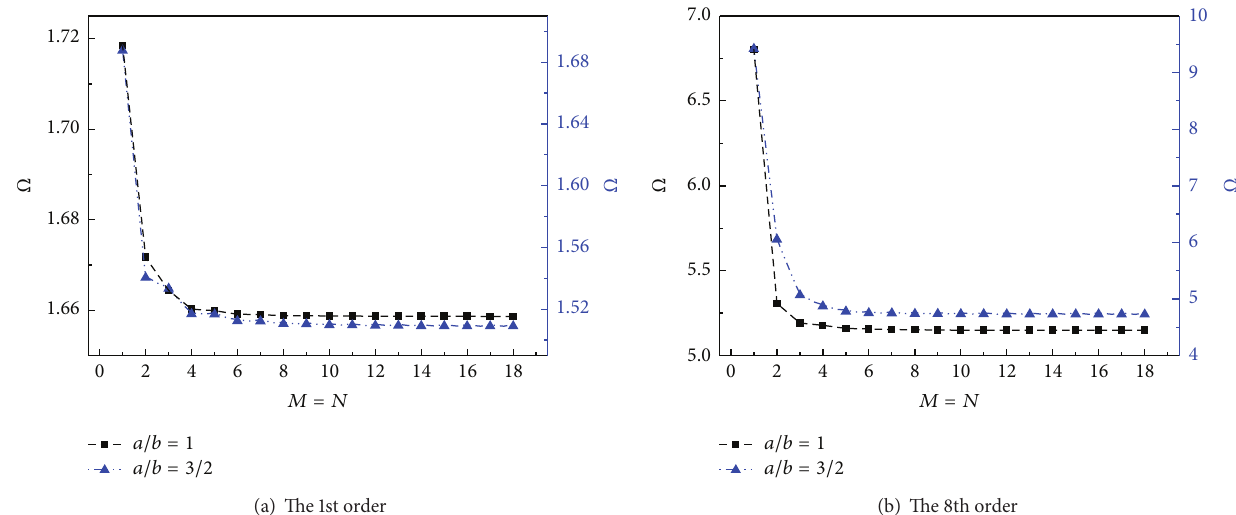
Figure 5: The effect of numerically truncated numbers 𝑀 = 𝑁 on the natural frequencies Ω with four edges elastically restrained against translation and rotation ( 𝐾 𝑇 = 𝑘 𝑖 /(𝑏 3 /𝐷) , 𝐾 𝑅 = 𝐾 𝑖 /(𝑏/𝐷) , 𝐾 𝑇 = 100 , and 𝐾 𝑅 = 100